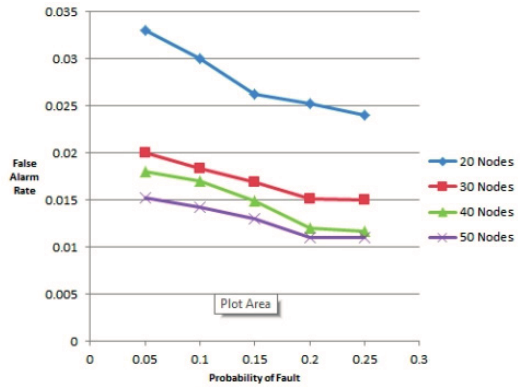
Figure 4. Probability of fault vs. false alarm